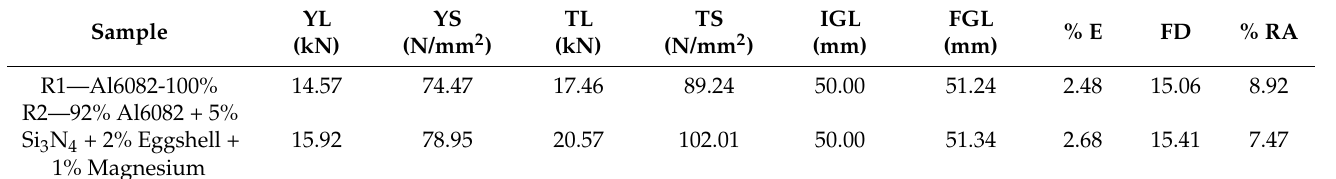
Table 5. Tensile strength test value.